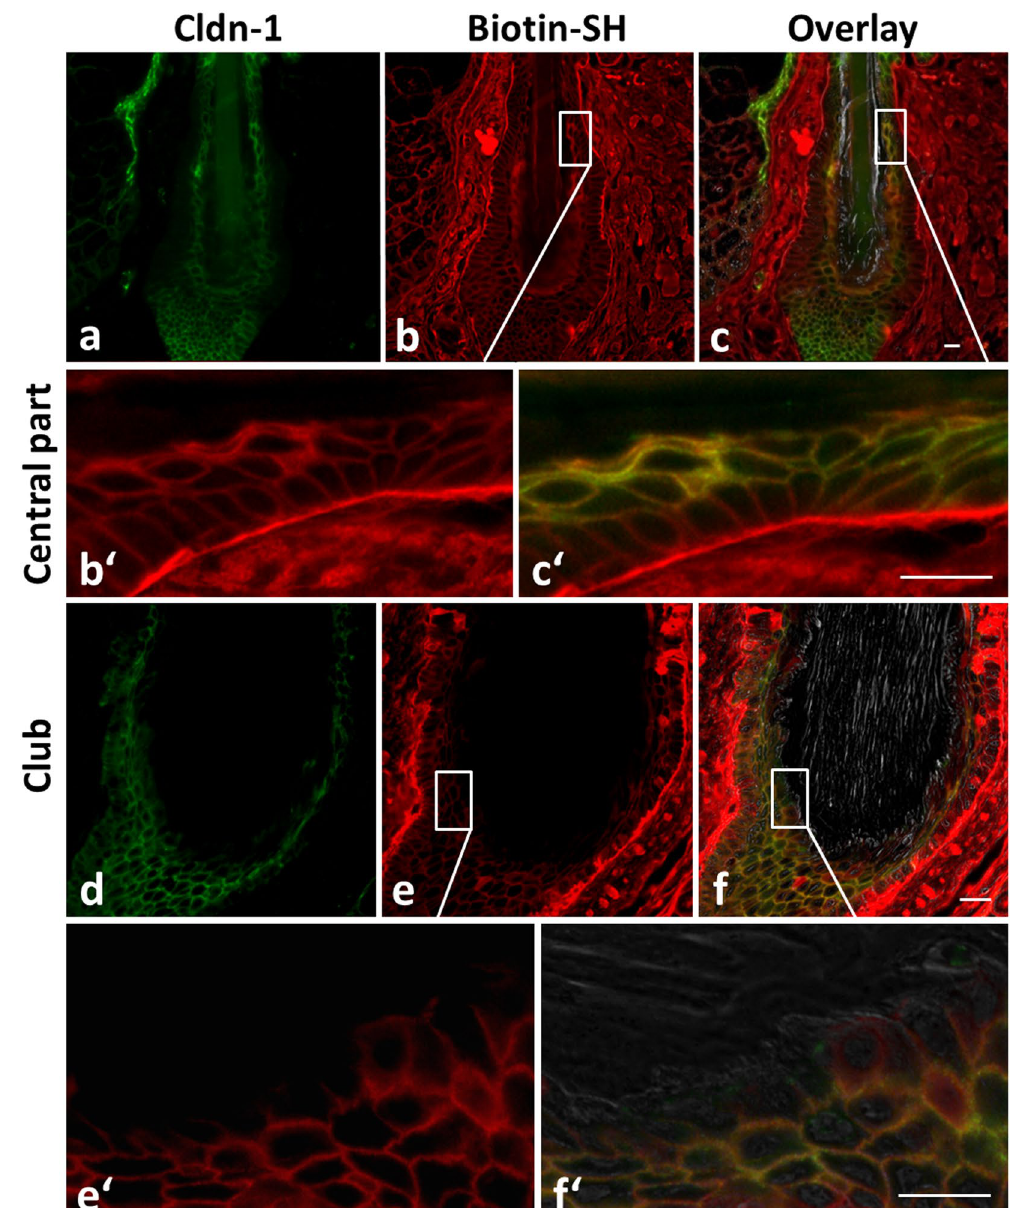
Figure 6. Localization of Cldn-1 and TJ barrier in human club hair follicles. Immunohistochemical stainings of Cldn-1 (green; a,c ,c ′ , d , f ,f ′ ) and Biotin-SH (red; b ,b ′ , c ,c ′ , e ,e ′ , f ,f ′ ) in the central part and around the brush of a club hair. ( c,c ′ , f ,f ′ ) overlay of Cldn-1, Biotin-SH and phase contrast. (b ′ ,c ′ ,e ′ and f ′ ) represent magnifications of ( b , c , e , and f ) (which are rotated for 90°) showing that Biotin-SH permeation stops at the keratinized club. Scale bars: 20 µ